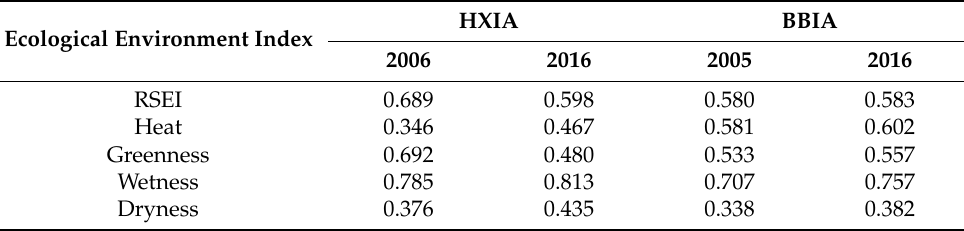
Table 1. Changes in and comparison of the overall ecological environment quality before and after the construction of the two